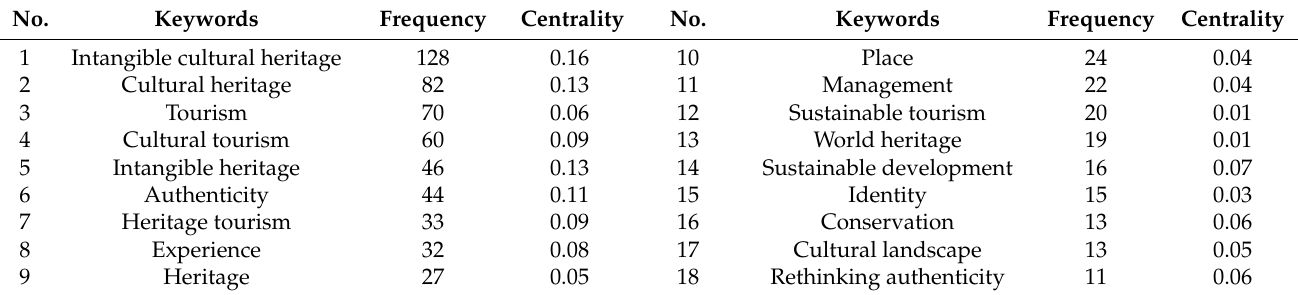
Table 2. Top 18 high-frequency keywords in foreign